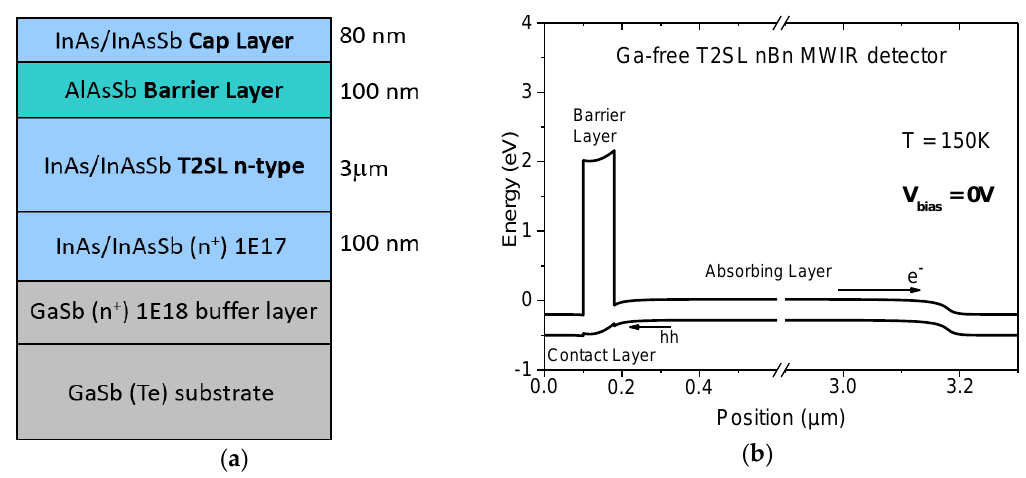
Figure 3. ( a ) Schematic diagram of the nBn device structure dedicated to electrical measurements. ( b ) Calculated energy band diagrams of the Ga-free nBn barrier detector structure at 150 K and 0 V.